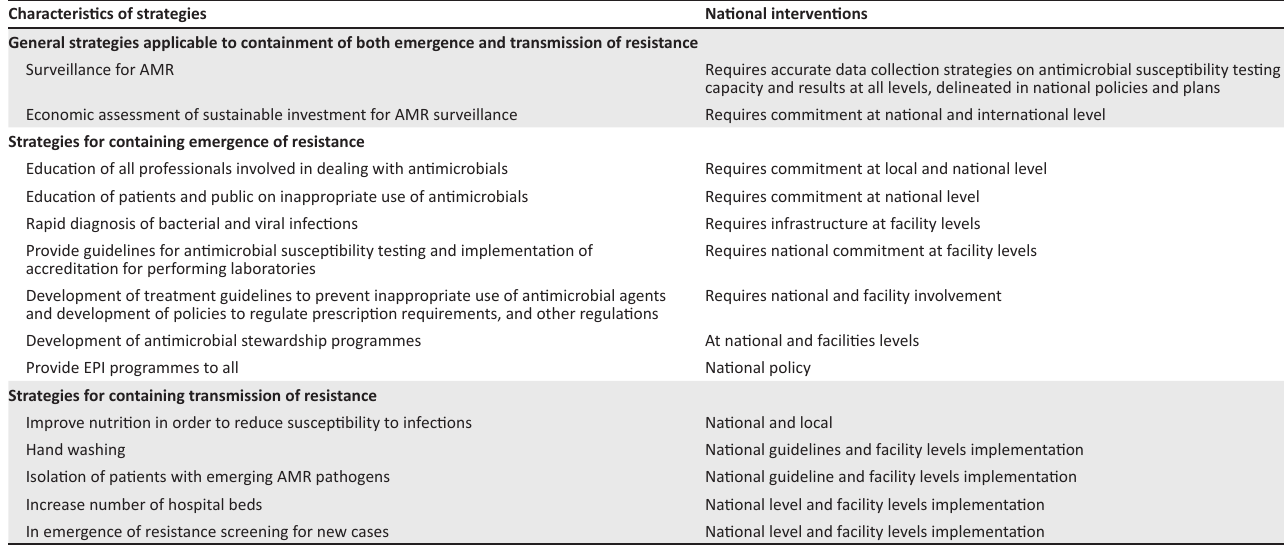
TABLE 1: Strategic planning for antimicrobial resistance interventions aligned with the World Health Organization Global Action Plan. 10 Characteristics of strategies National interventions